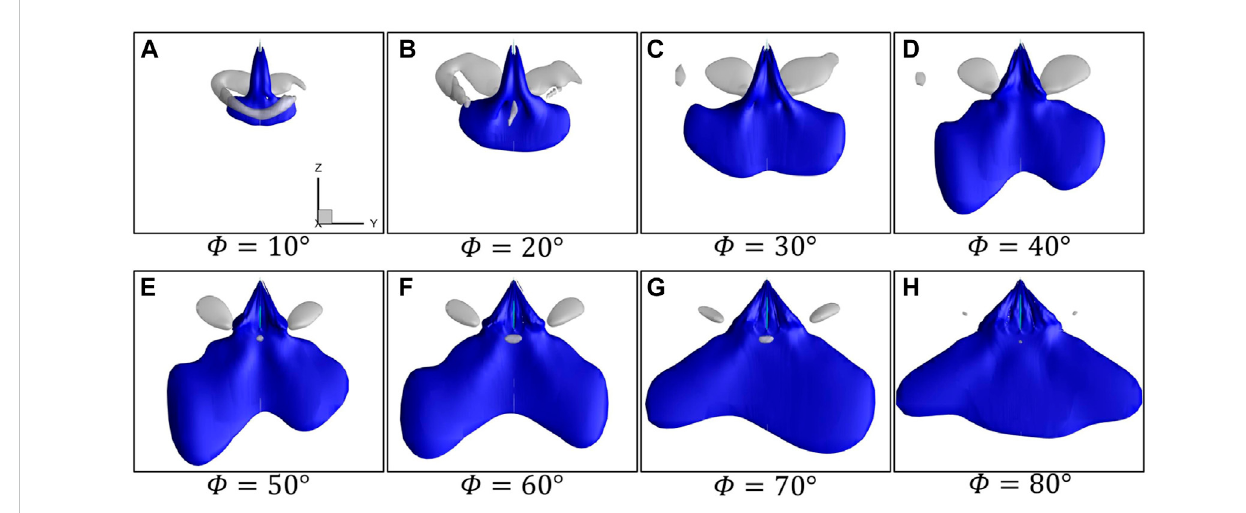
FIGURE 7 Iso-surfaces of time-averaged velocity u Z thresholded at 0.2 (gray) and -0.3 (blue) of a single wing for different fl apping amplitudes Φ (A – H)